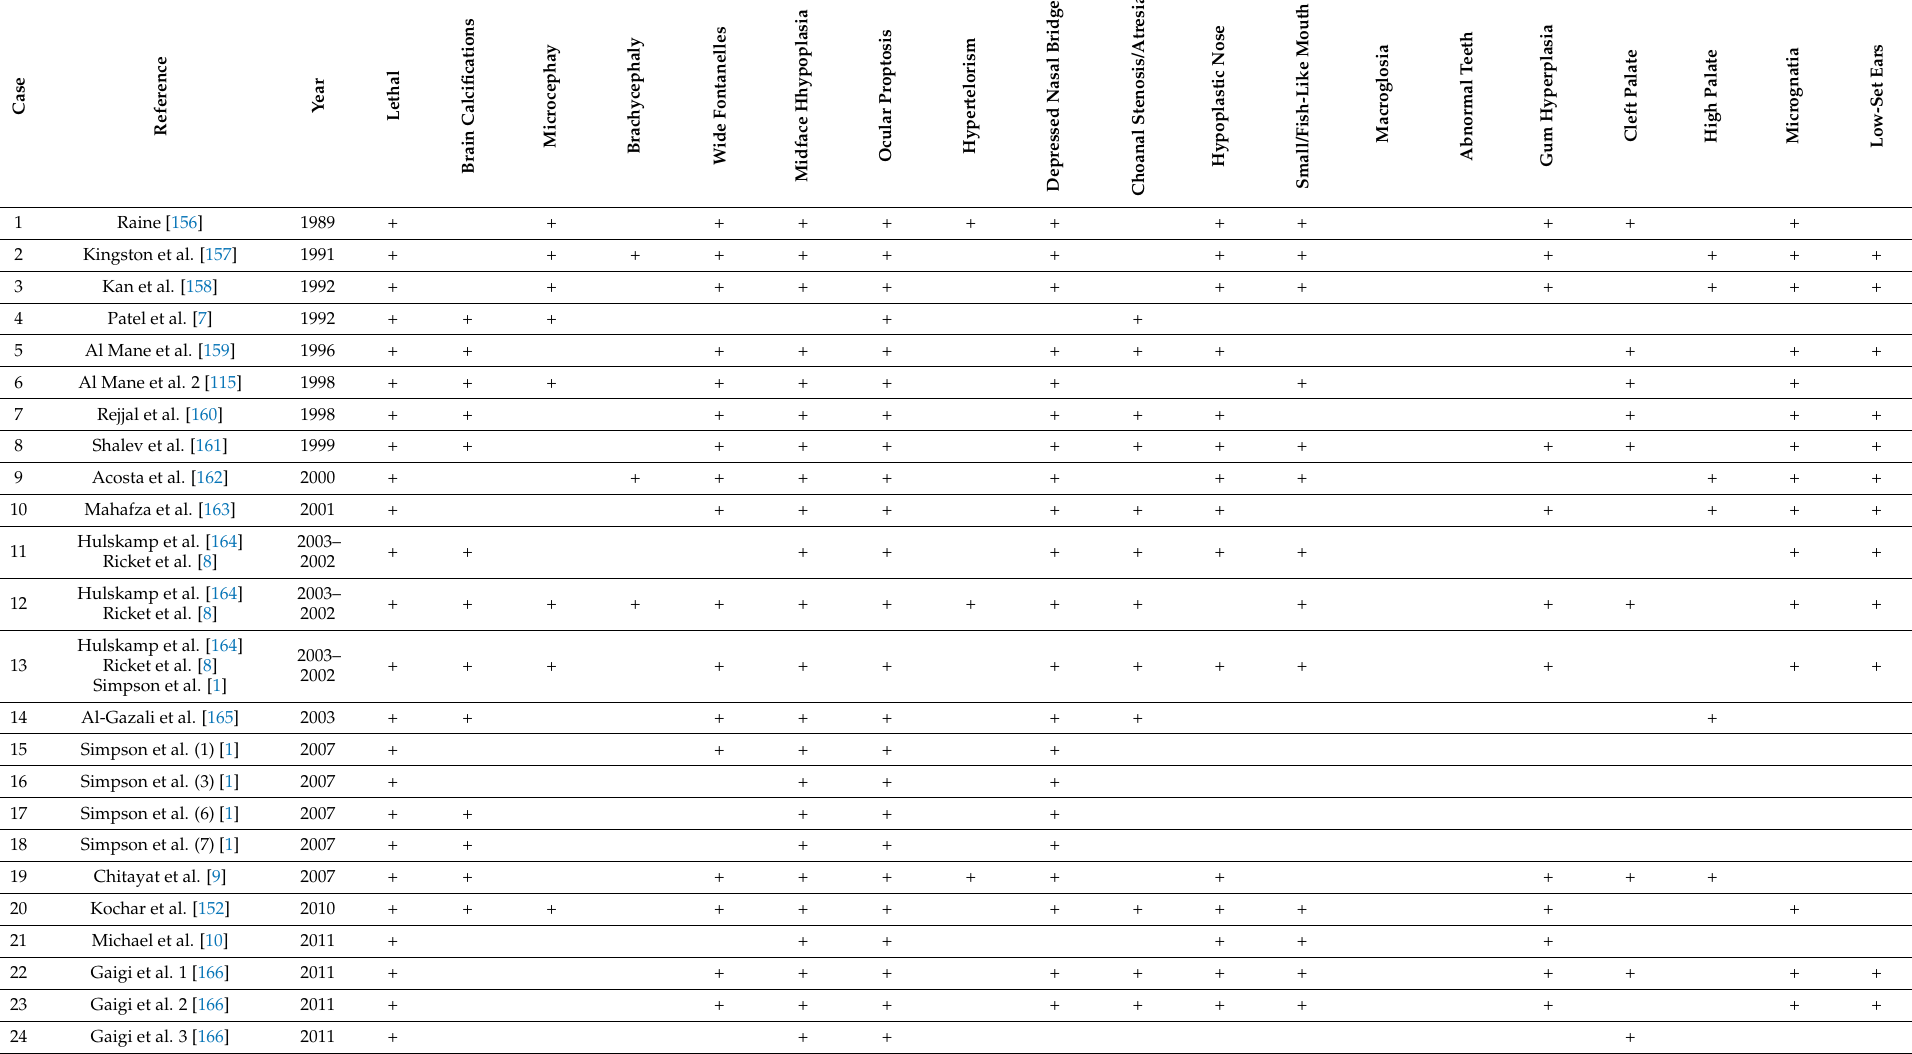
Table 3. Craniofacial features of LRS